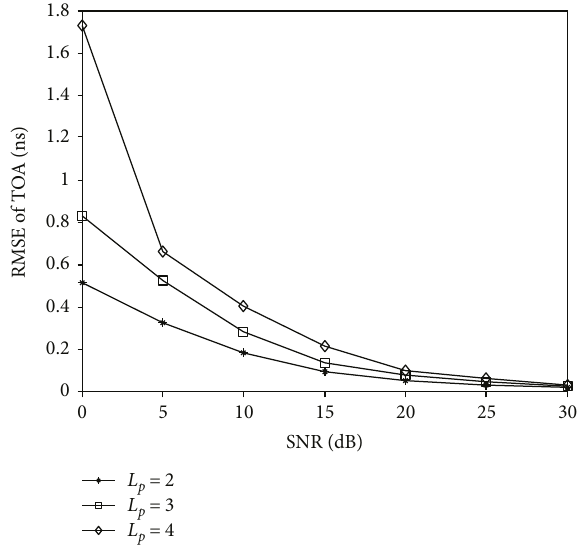
Figure 8: TOA estimation performance of the fi rst path under di ff erent multipath